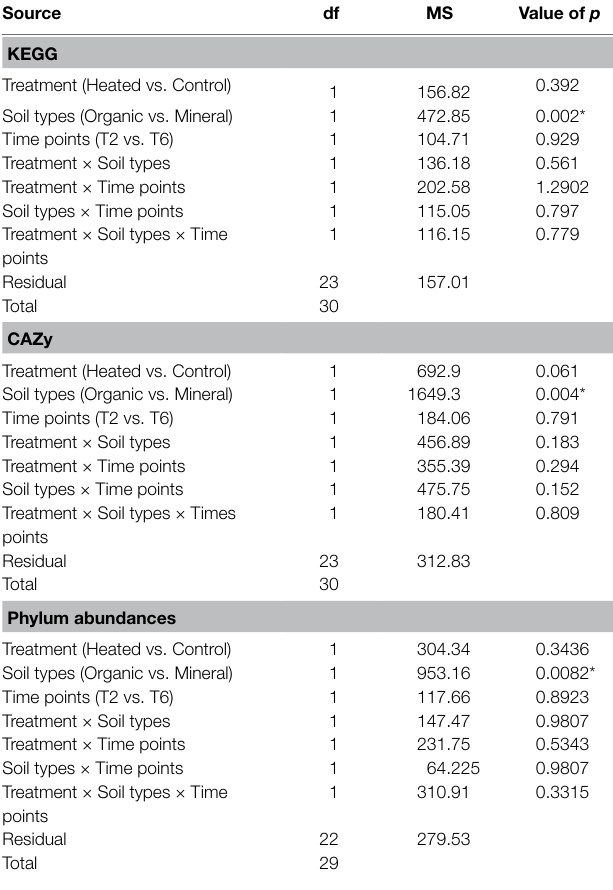
TABLE 3 | Multivariate analyses – three-factor multivariate PERMANOVA analyses based on Bray-Curtis similarity of KEGG transcripts, CAZy transcripts, and phylum